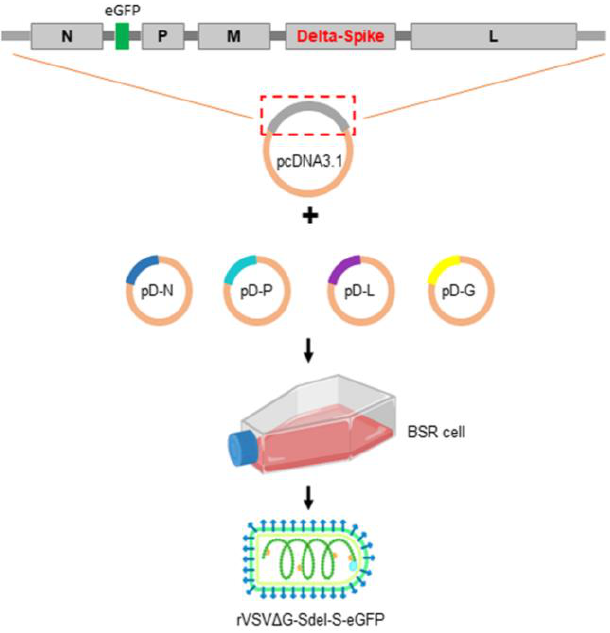
Figure 1. Scheme diagram of the generation of recombinant vesicular stomatitis virus rVSV ∆ G-Sdel-eGFP. The p3.1-VSV-eGFP plasmid in which its native glycoprotein gene was replaced with the SARS-CoV-2 Delta variant S protein gene to generate the recombinant full-length plasmid (named p3.1-VSV ∆ G-Sdel). The recombinant full-length plasmid and four helper plasmids were